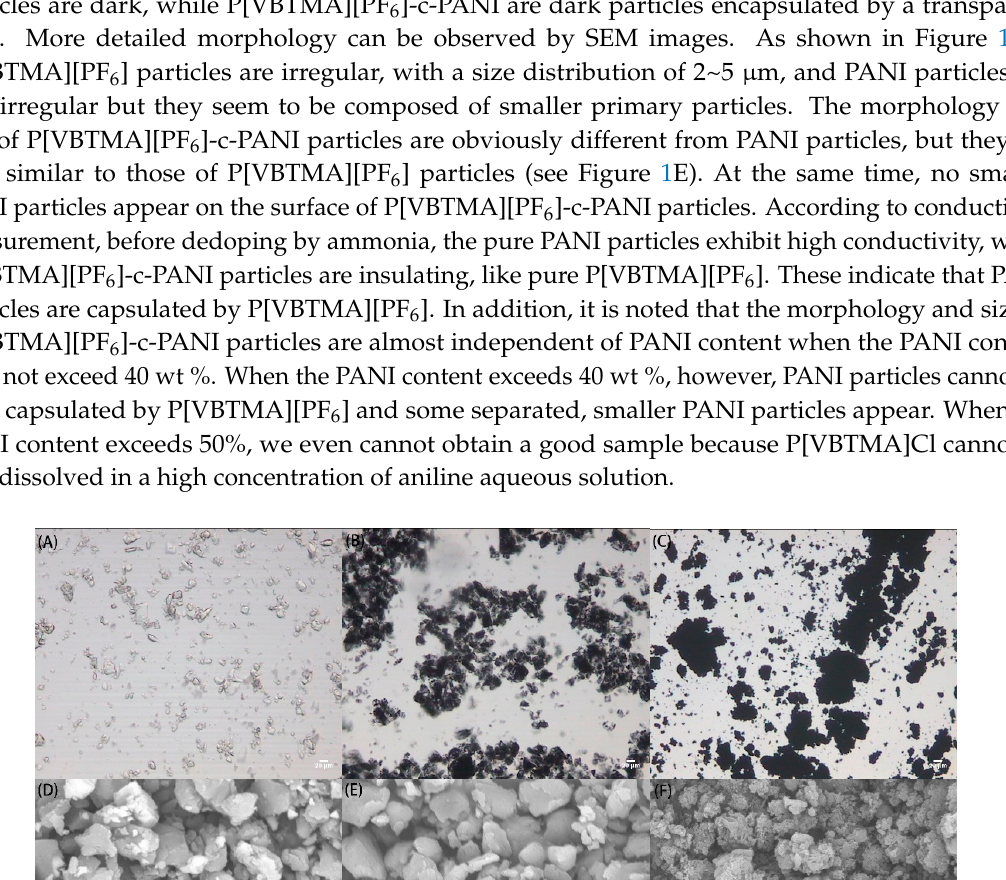
Figure 1. Optical microscopy photos ( A – C ) and scanning electron microscopy (SEM) images ( D – F ) of